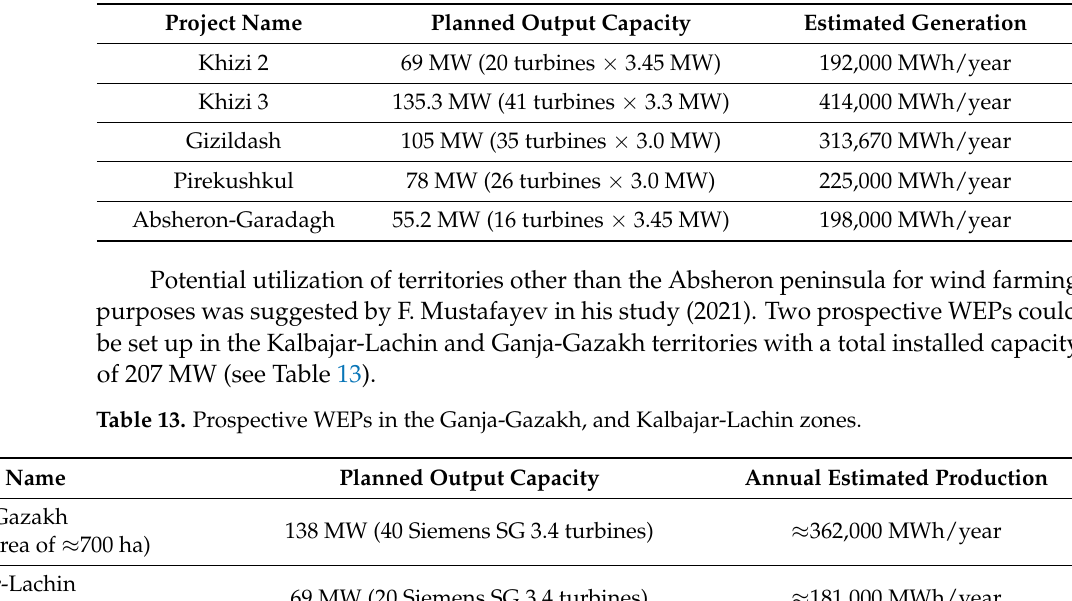
Figure 9. Wind power density at 100-m altitude [33].